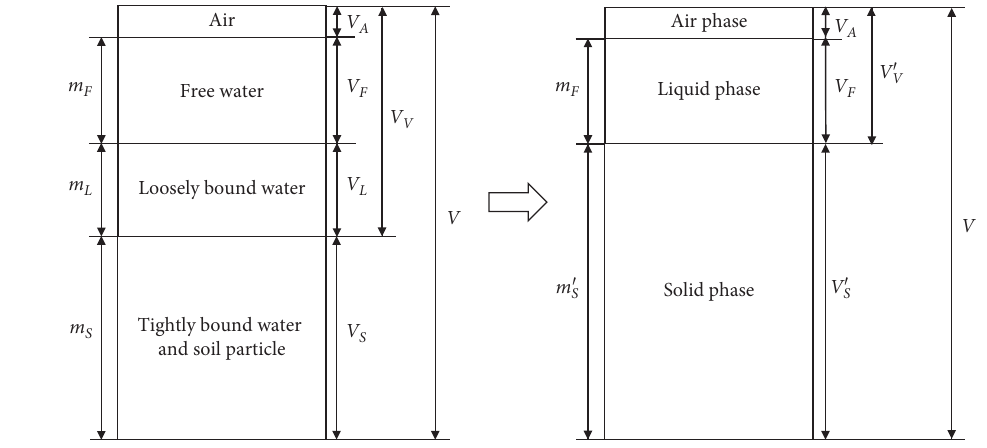
Figure 1: Three-phase schematic diagram of soil considering LBW. Table 1: Physical properties of different soil